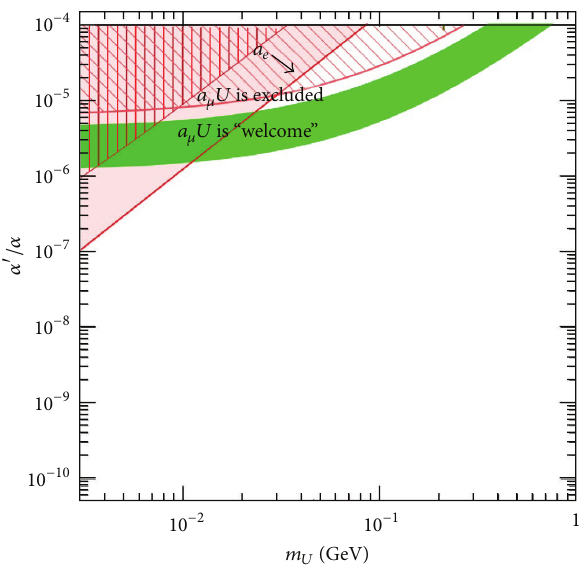
Figure 3: Exclusion region in the hypothesis of invisible 𝑈 boson, coupling to